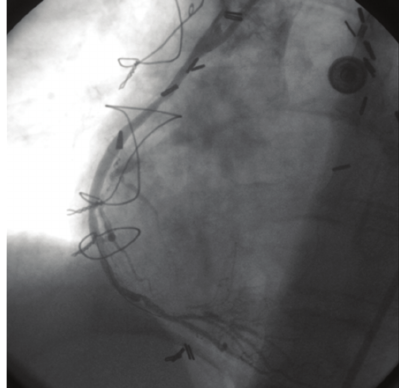
Figure 2: After balloon dilatation.